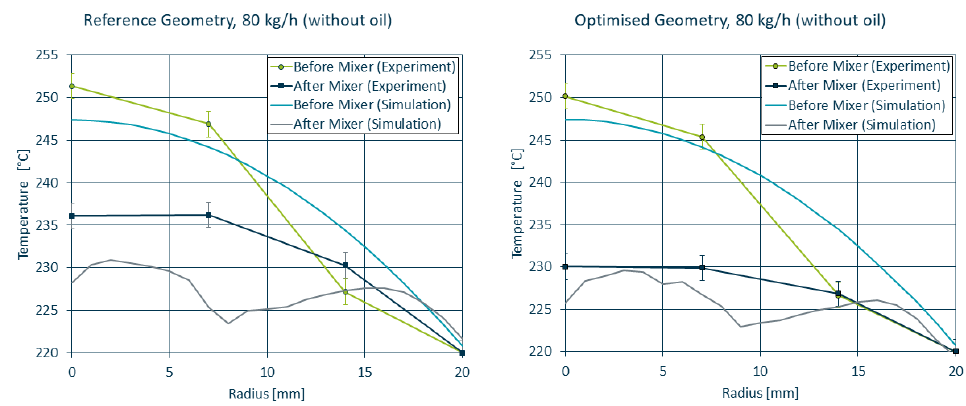
Figure 12. Simulated and measured temperature curves before and after the static mixer for the reference ( left ) and optimised ( right ) geometry.